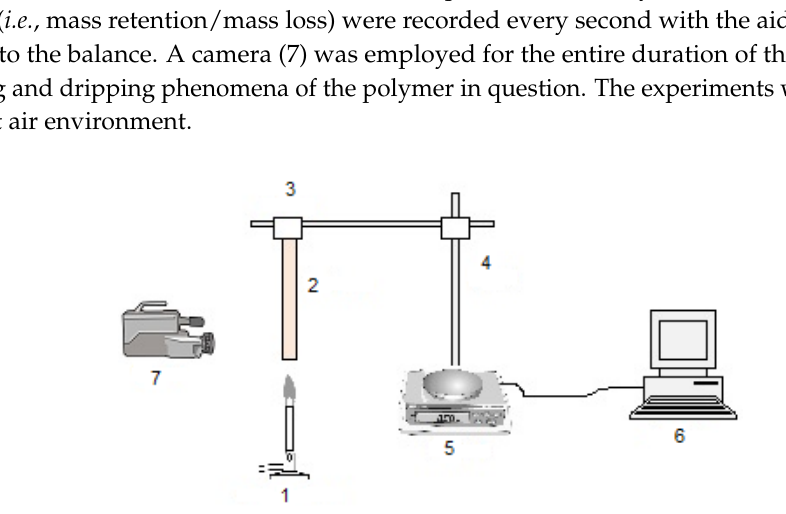
Figure 1. A schematic sketch of the experimental set-up for the UL-94 vertical test: 1—Bunsen burner; 2—tested polymer sample; 3—clamp; 4—bracket; 5—balance; 6—computer; 7—camera (used by Wang et al. [5,13]).